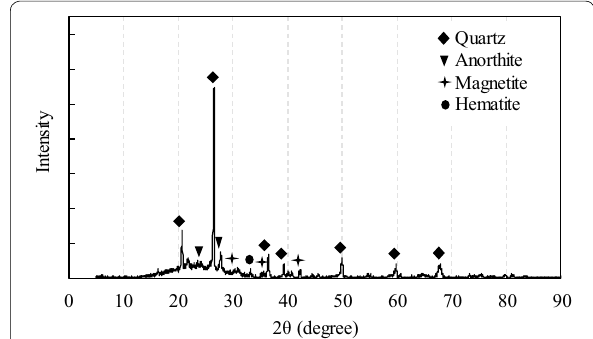
Fig. 1 X–ray diffraction patterns of the lightweight aggregates used.